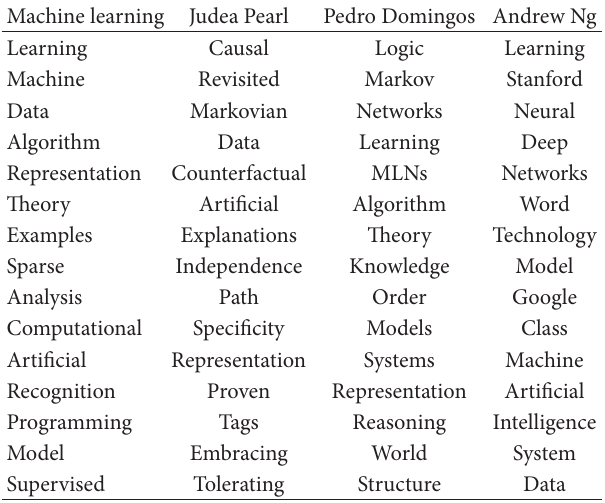
Table 4: Machine learning’s topic prior ( 𝜑 𝑧 ) and word distributions ( 𝜑 𝑒,𝑧 ) of its related